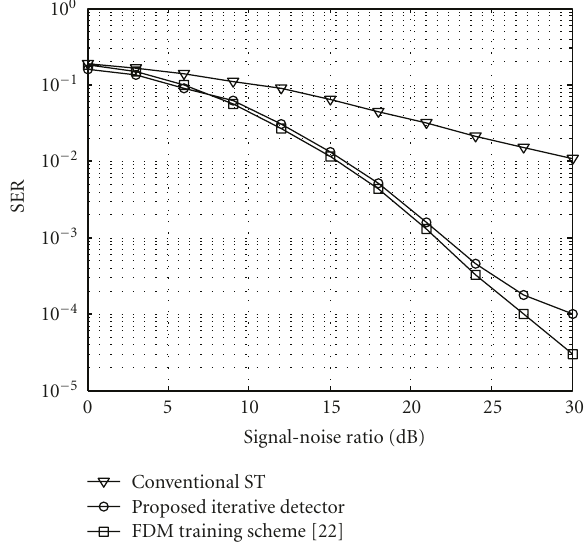
Figure 6: SER versus SNR for di ff erent demodulator with E p = 0 . 01E s of f d = 300